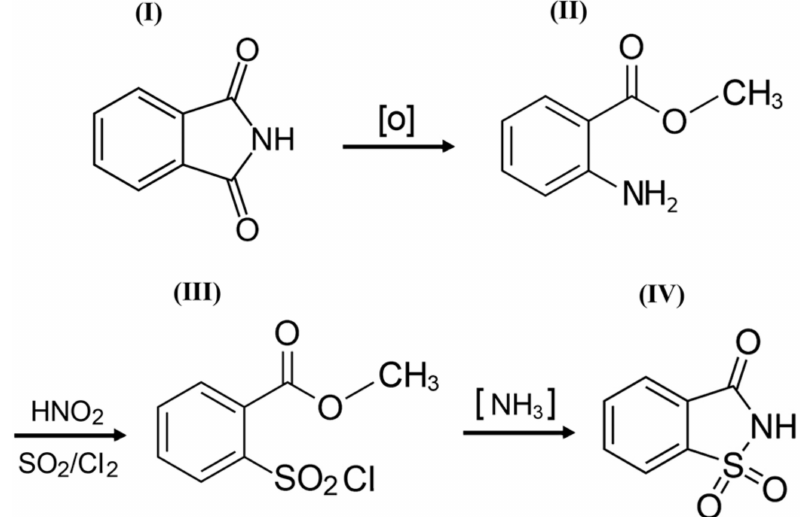
Figure 2. A simplified scheme of the sequence of chemical reactions in the conversion of phthalimide ( I ) to o -benzoic sulfimide ( IV